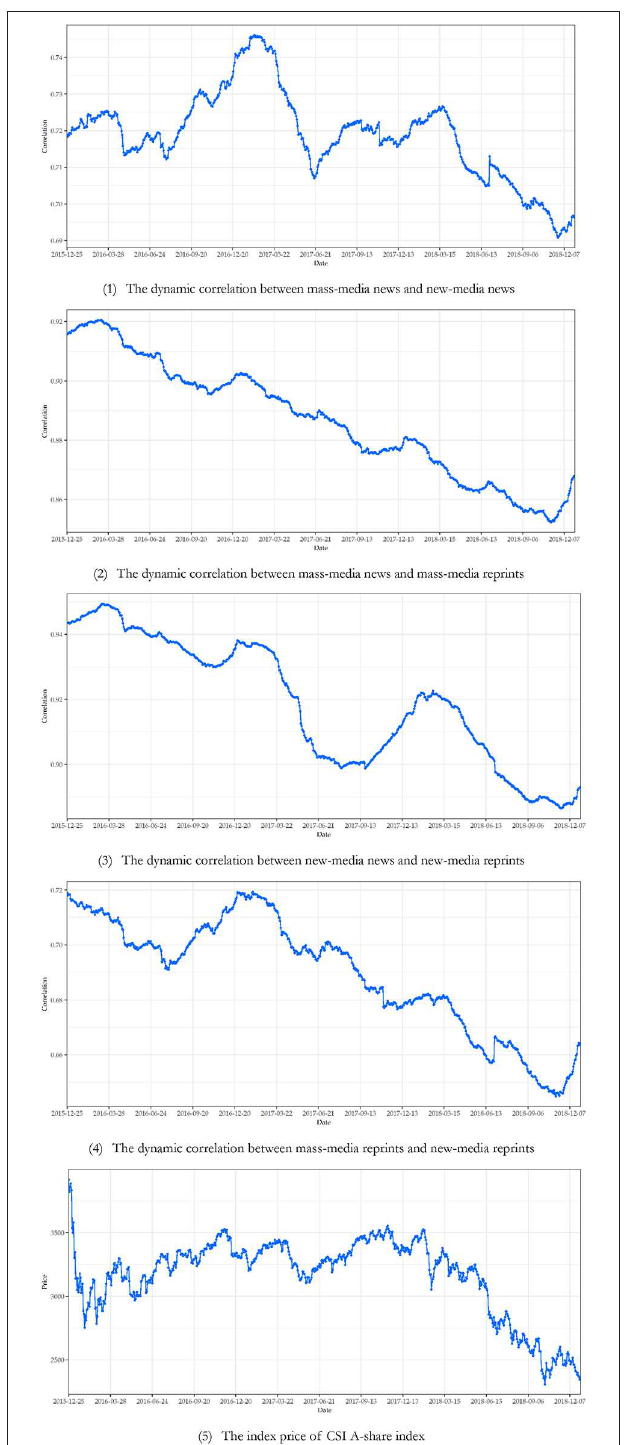
FIGURE 2 | The dynamic correlation for four types of news and stock